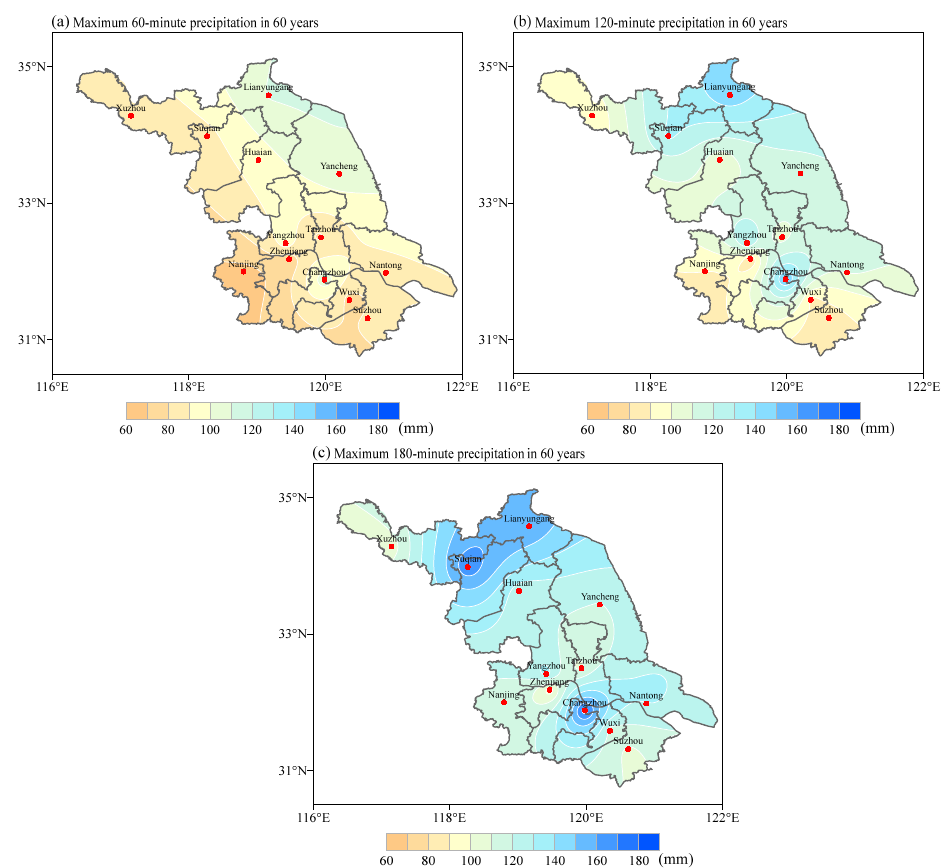
Figure 3. Maximum precipitation distributions of ( a ) 60 min, ( b ) 120 min, and ( c ) 180 min rainstorms from 1961 to 2020 in Jiangsu Province.